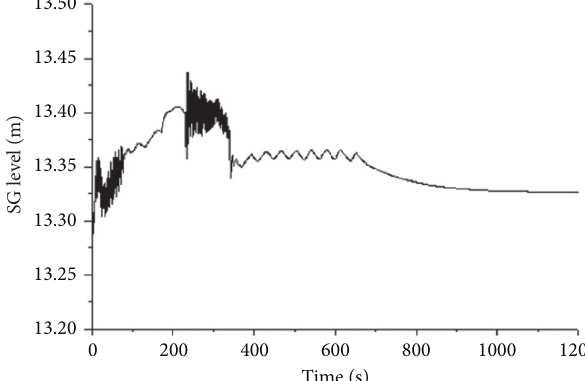
Figure 7: The transient water level of the evaporator with the linear increase in the